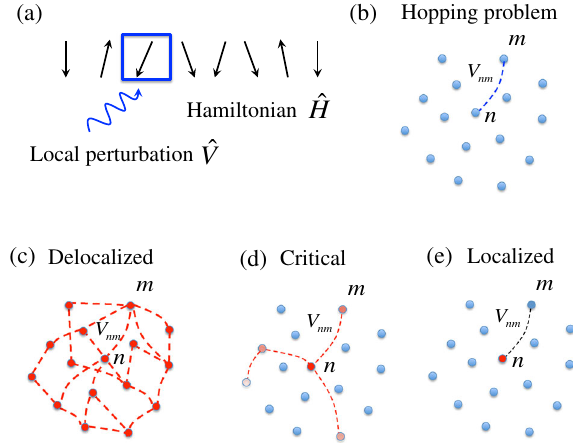
FIG. 1. (a) The system is perturbed by a local physical operator ˆ V ˆ H that mixes the eigenstates of the unperturbed Hamiltonian , leading to an effective hopping problem shown in panel (b). Vertices of the lattice correspond to the unperturbed eigenstates, ˆ V and matrix elements of the operator determine the hopping amplitudes. Bottom panels illustrate the possible outcomes of a local perturbation applied to the Hamiltonian: All the eigenstates are mixed in the ergodic phase [panel (c)], whereas in the MBL phase, the perturbation admixes a finite number of states [panel (e)]. In the critical regime [panel (d)], the eigenstates are expected to be multifractal